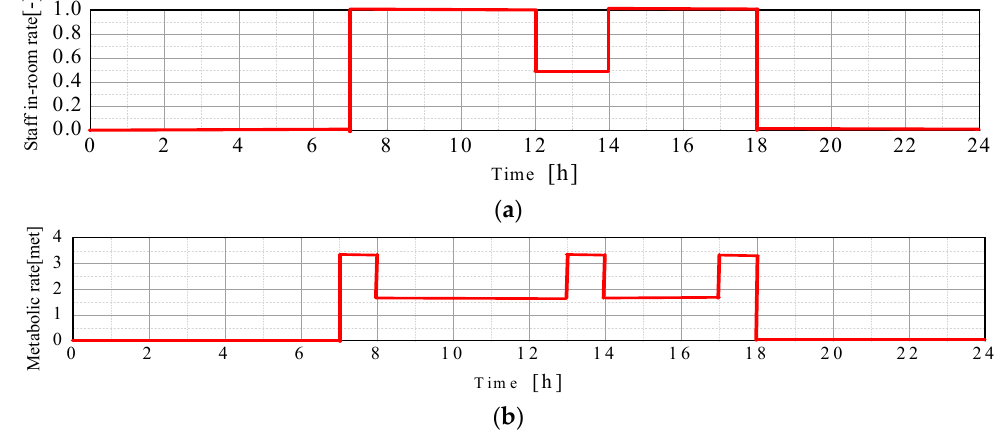
Figure 3. Office staff in-room rate and energy metabolism of staff in corridors hourly during work time. ( a ) Office staff in-room rate hourly in working time; ( b ) energy metabolism of staff in corridors hourly in working time.